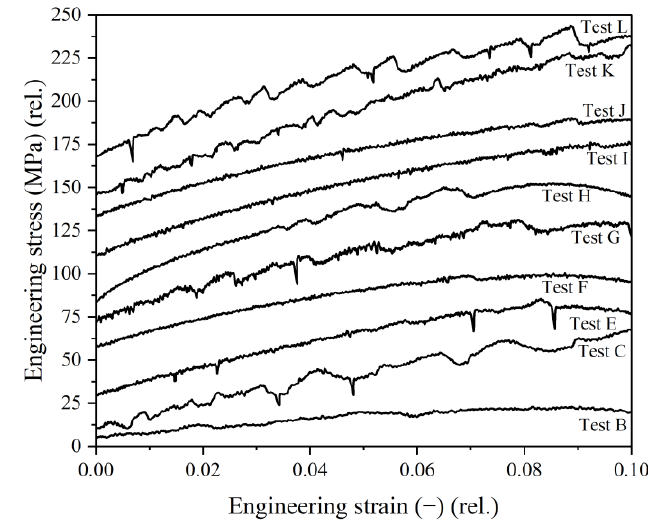
Figure 7. Comparison of serrated sections of engineering stress–strain curves of all tests performed at elevated temperatures. The stress and strain scales were identical for all tests, in order to be able to compare serration amplitudes and frequencies.